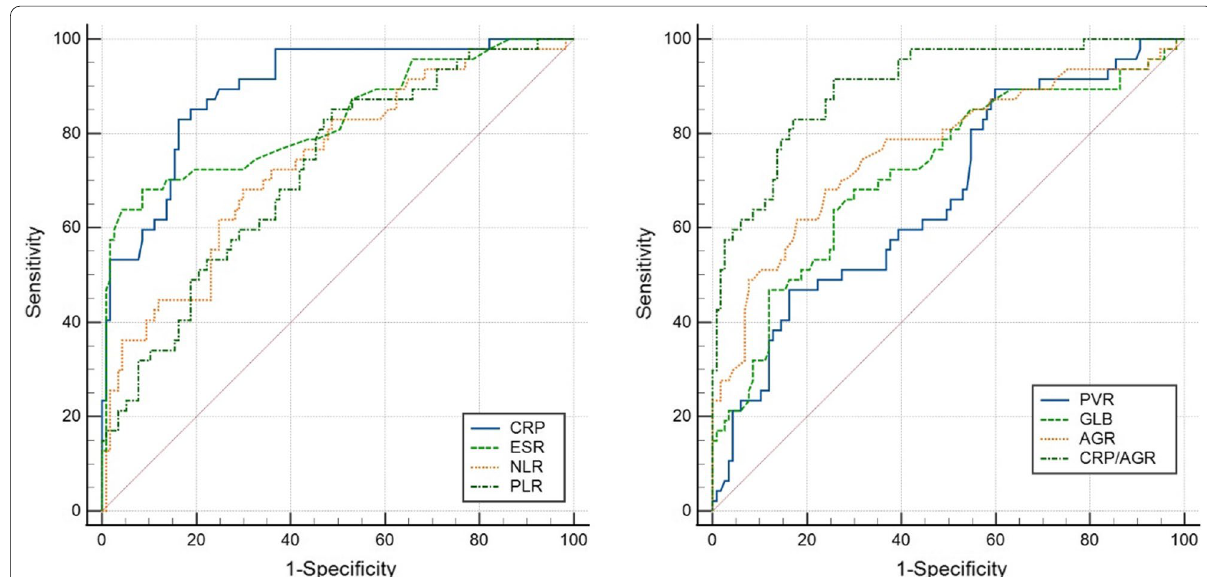
Fig. 3 ROC curves for the diagnosis of PIJ based on NLR, PLR, PVR, GLB, AGR, and CRP/AGRrelative to CRP and ESR (traditional biomarkers)